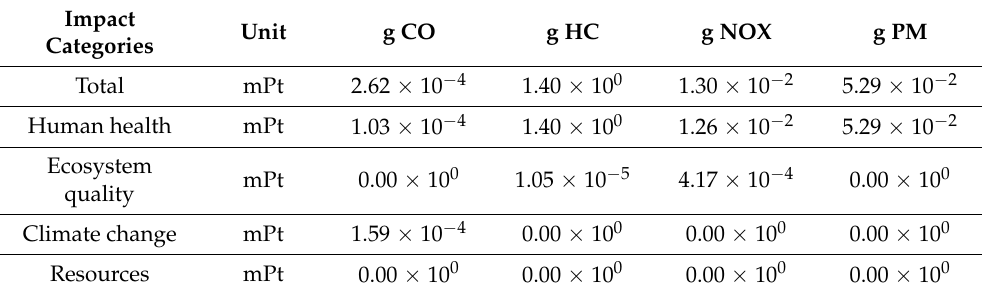
Table 2. Environmental impact per gram of emissions according to the IMPACT2002+